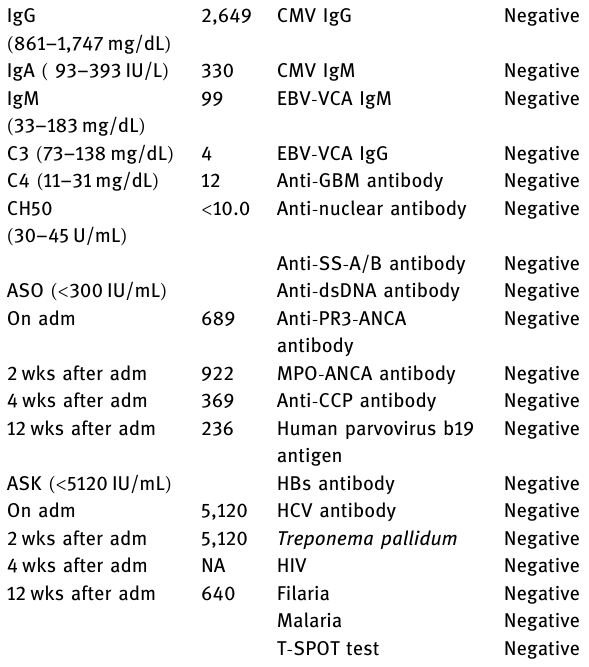
Table 2: Immunological test